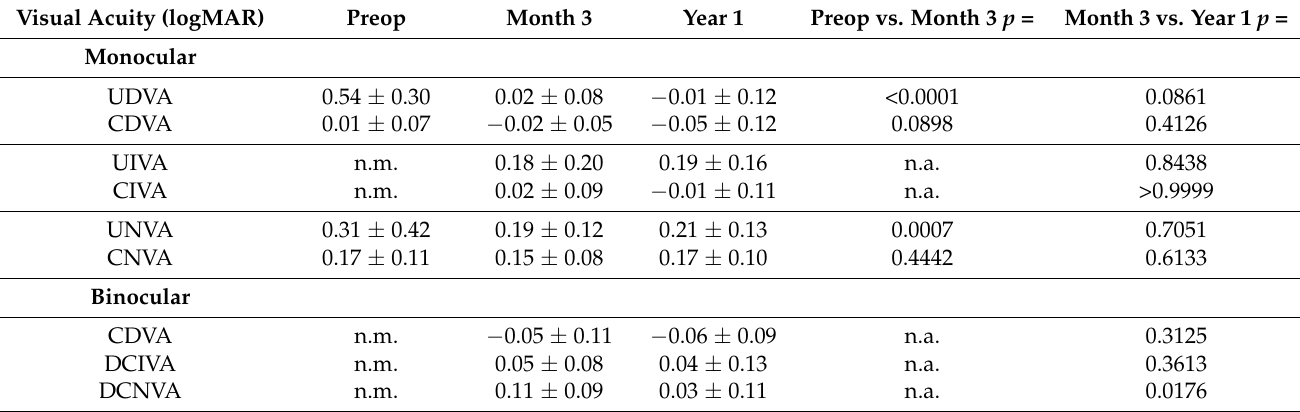
Table 3. Pre- and postoperative visual acuities (distance, intermediate, near) 1 .